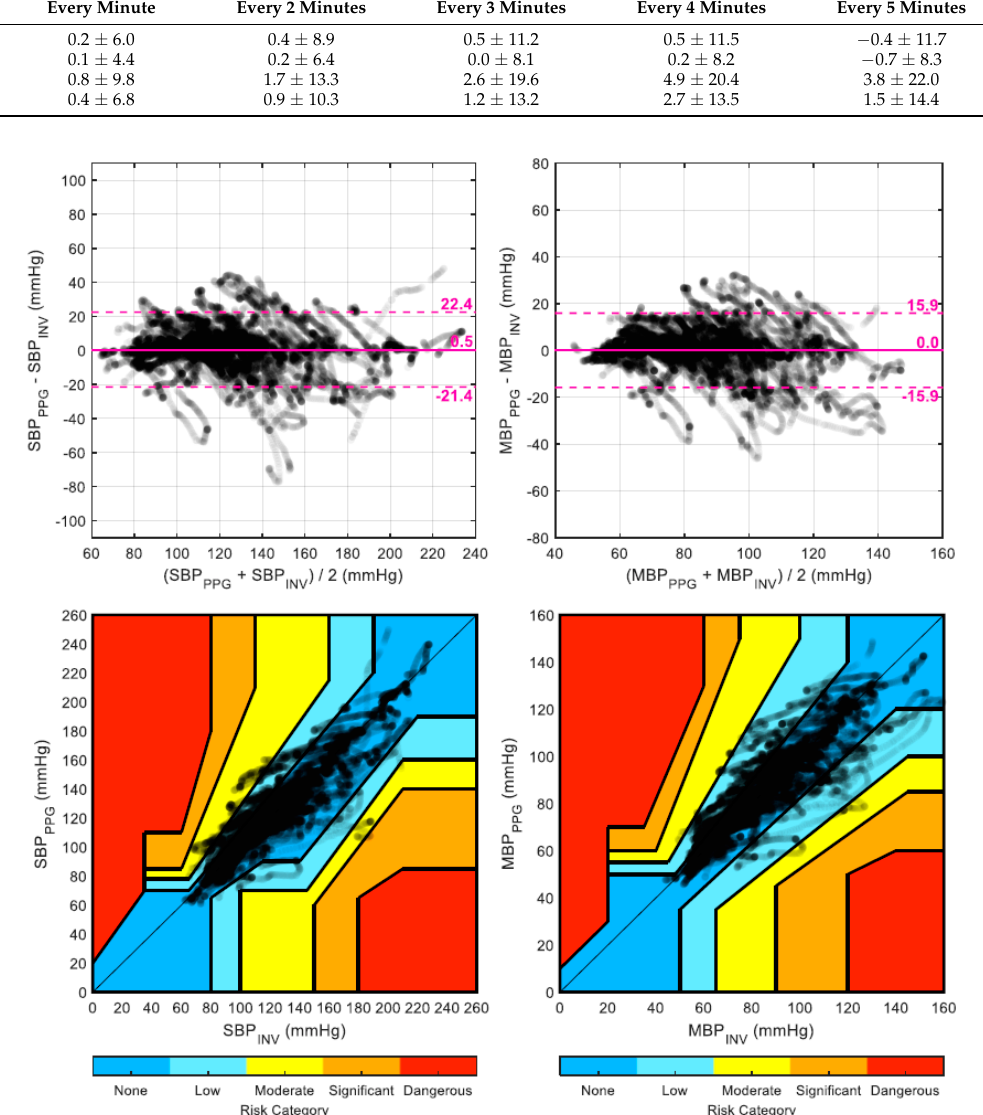
Figure 2. Bland-Altman plots and error grid analysis plots for BP PPG (SBP/MBP).